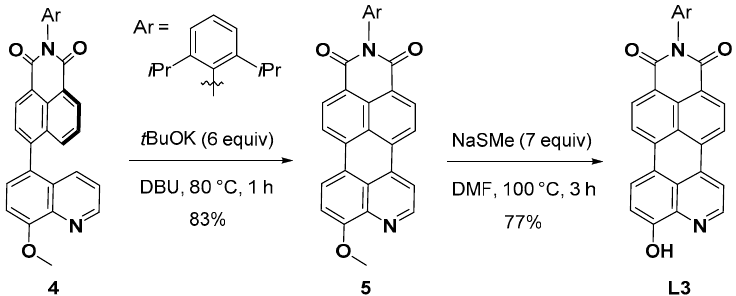
Scheme 2. Base-promoted intramolecular cyclization of 4 and subsequent deprotection of 5 to generate L3 .